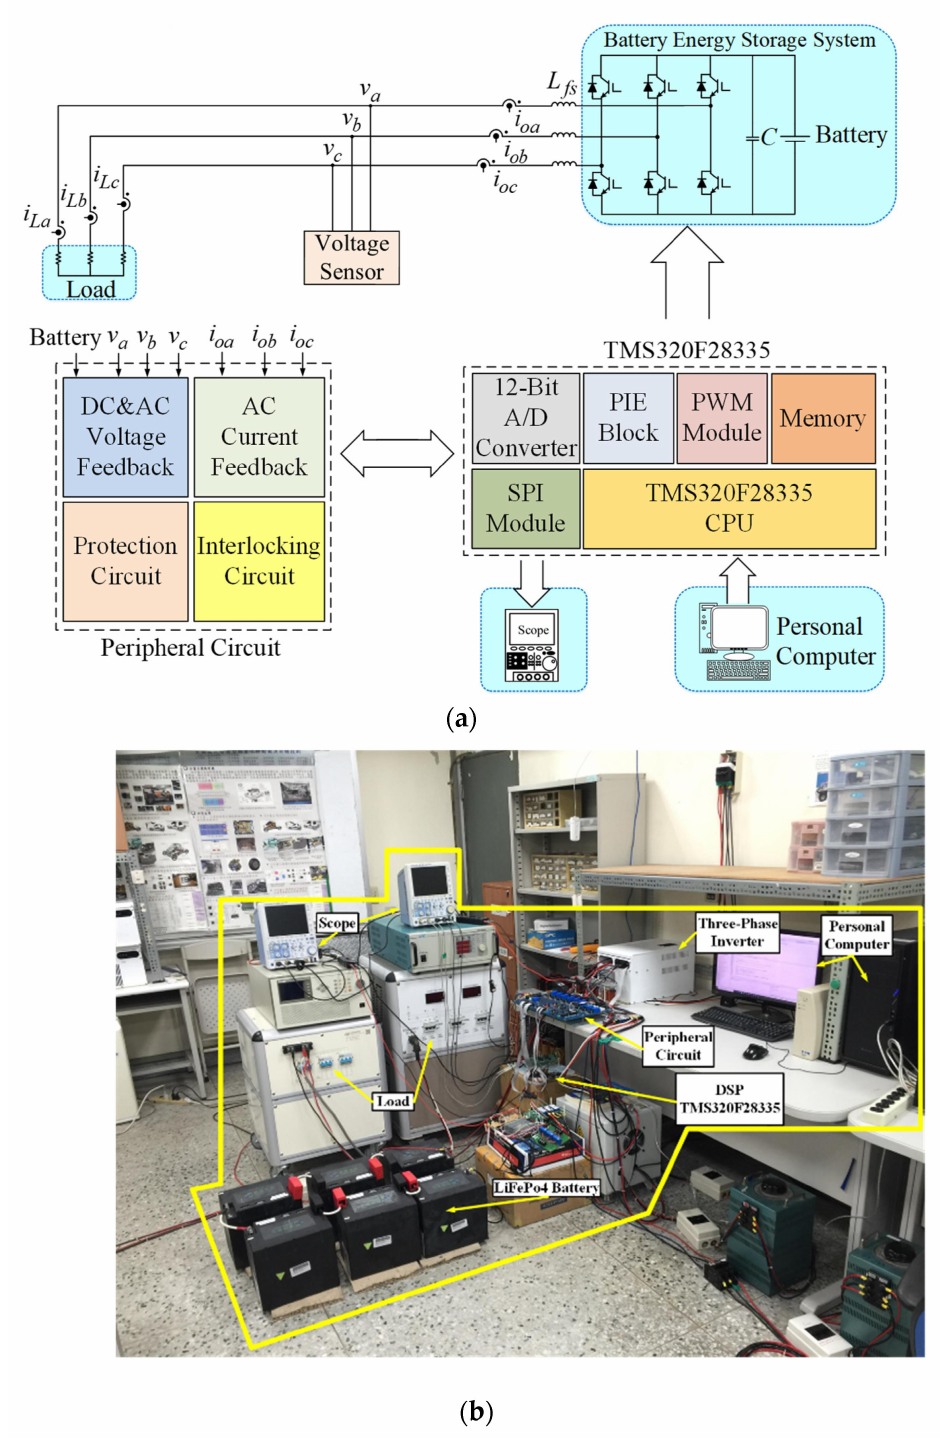
Figure 4. BESS using VSG control. ( a ) Block diagram of DSP-based BESS; ( b ) photo of experimental setup.